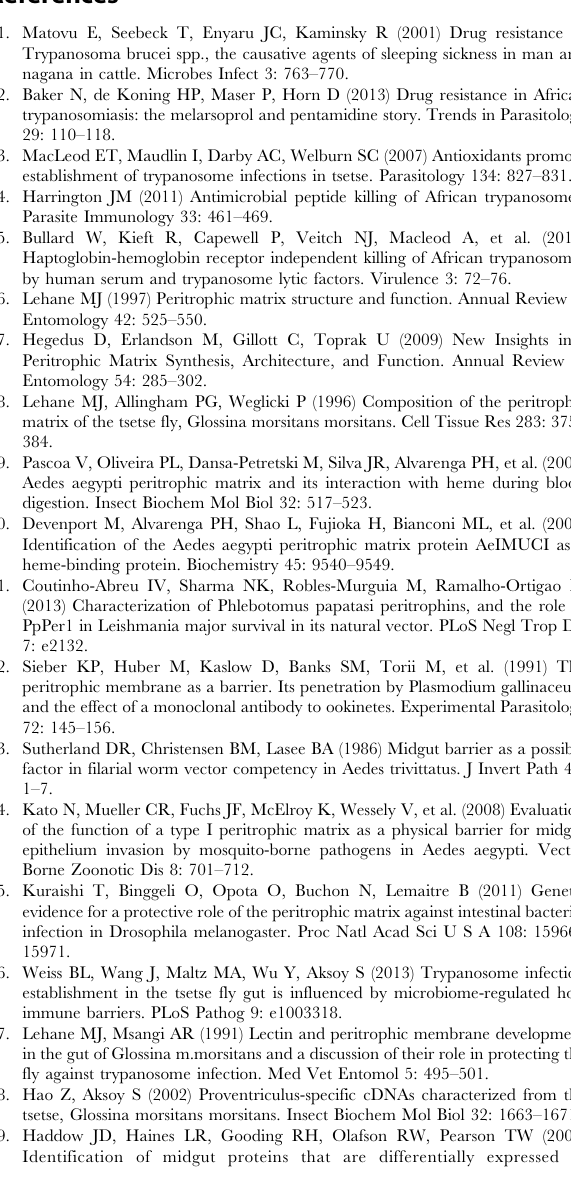
Table S3 Glossina morsitans Mascot data. Table S4 Sodalis glossinidius Mascot